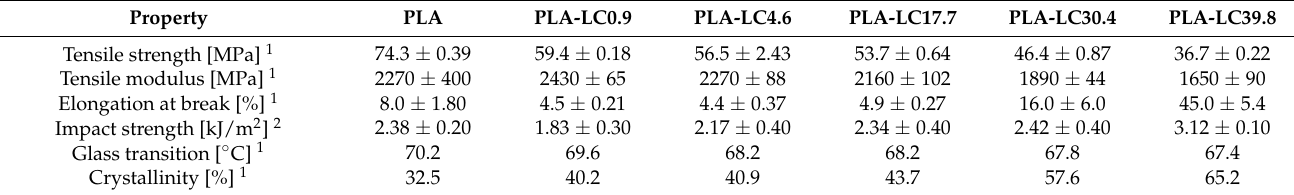
Table 1. Mechanical, thermal, and thermomechanical properties of PLA-based